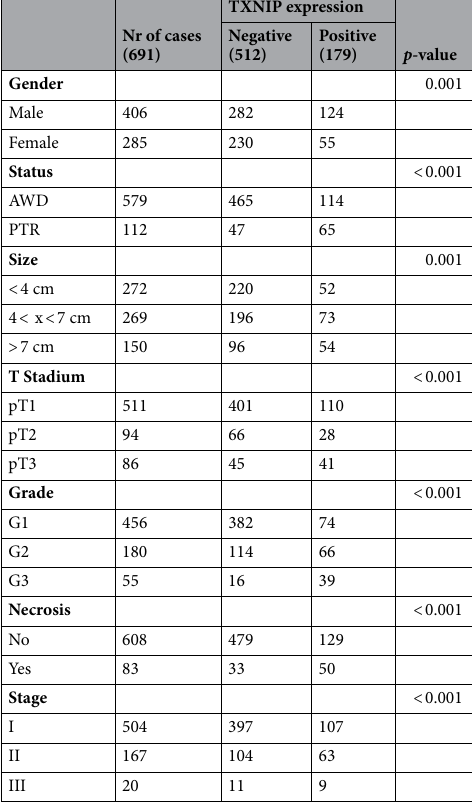
Table 1. Association of TXNIP expression with clinical-pathological parameters of conventional RCCs without metastasis at the time of operation (n = 691). AWD alive without disease, PTR postoperative tumour relapse.